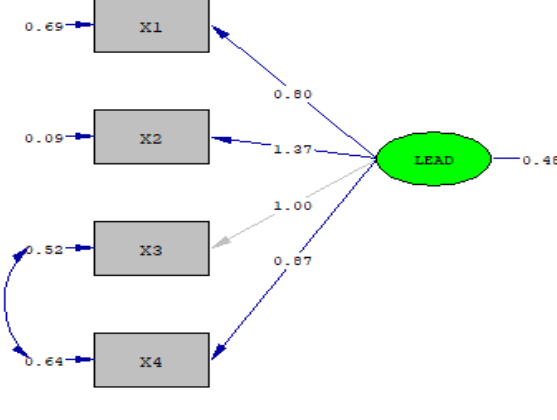
Figure 2. Measurement model of leadership variable of students .